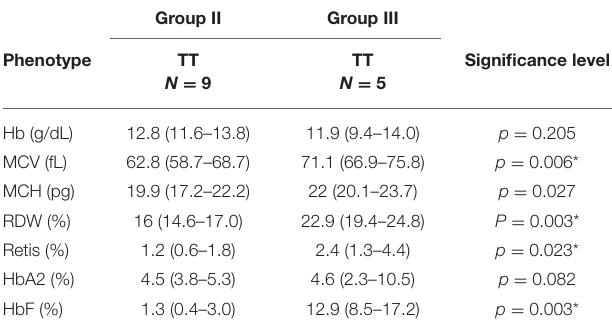
TABLE 6 | Comparison of means of hematological parameters in patients with thalassemia trait (TT) of group II and group